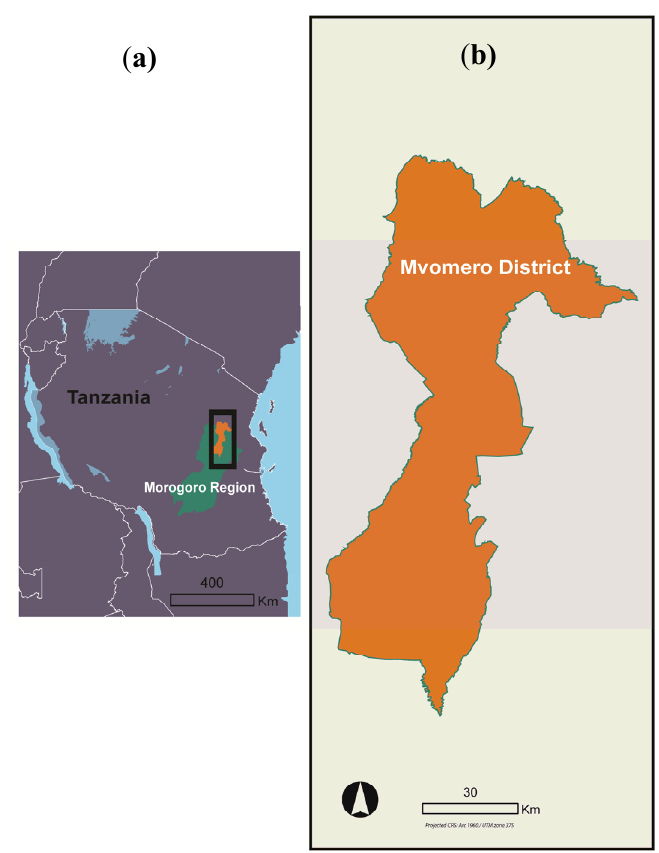
Figure 1. A map of ( a ) Tanzania and ( b ) Mvomero district.